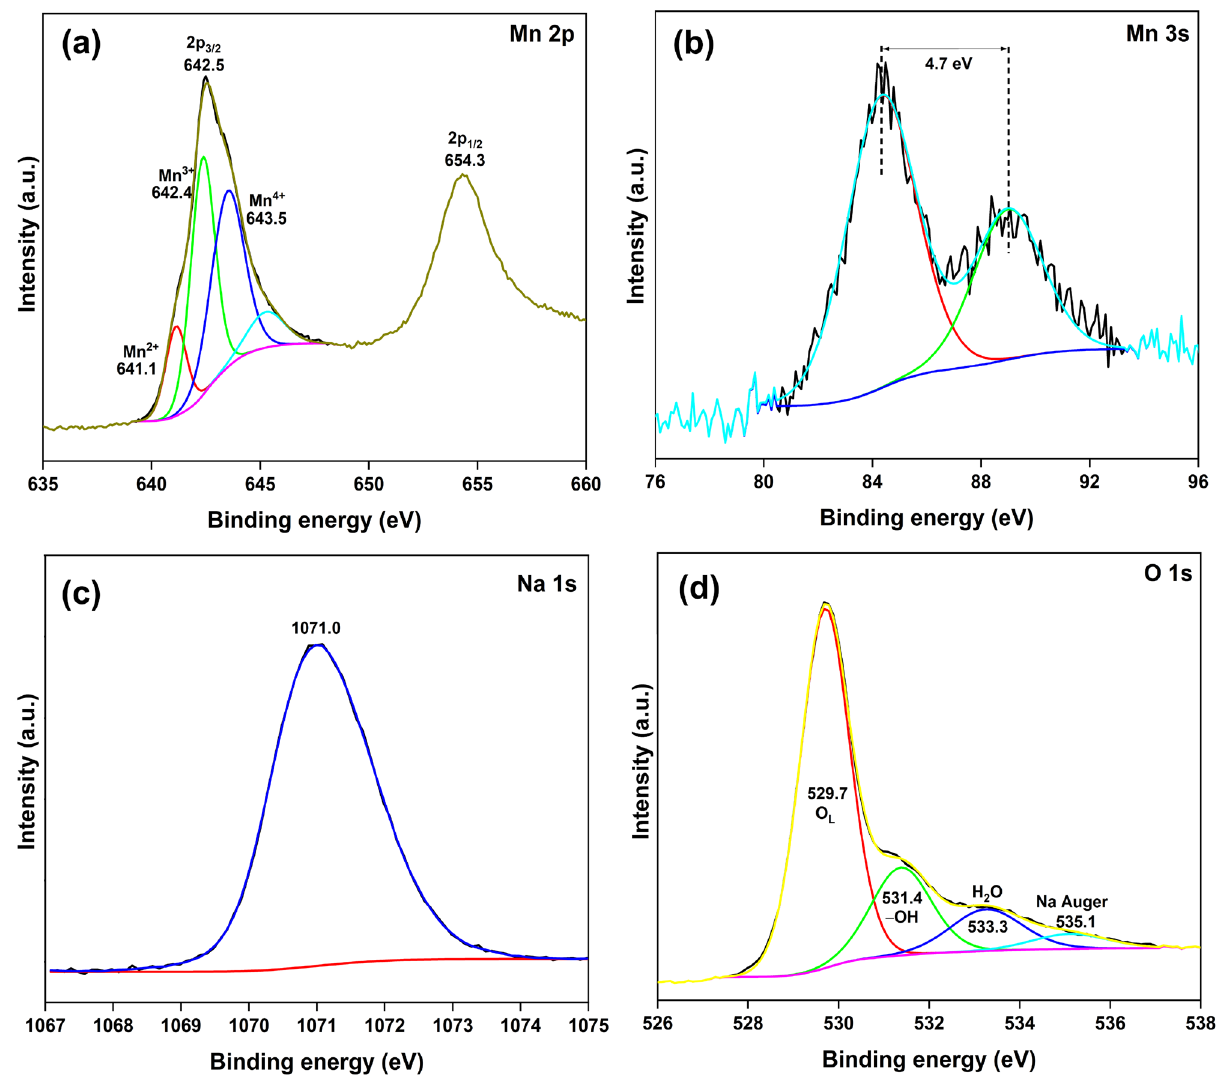
Figure 3. HRXPS ( a ) Mn 2p; ( b ) Mn 3s; ( c ) Na 1s; ( d ) O 1s spectra of